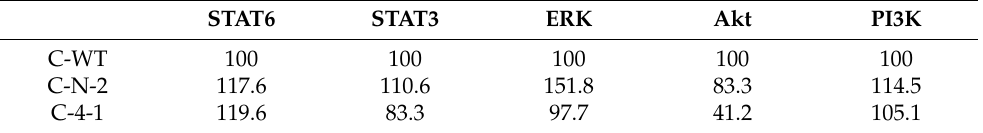
Table 1. Baseline expression of IL-13 signalling components in percent of WT expression. Expression was determined with ImageJ 1.52a and grey-scale values were corrected by loading control.